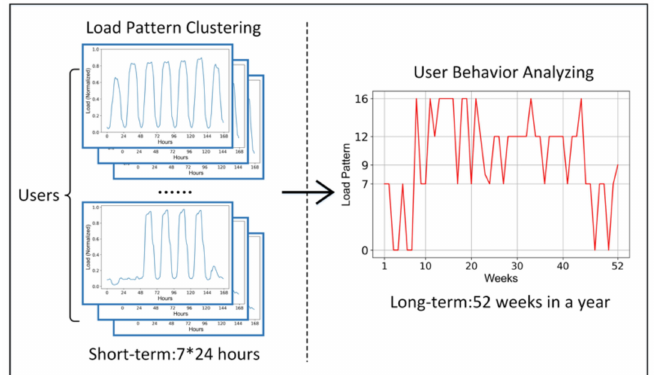
Figure 4. User data model conversion from short-term to